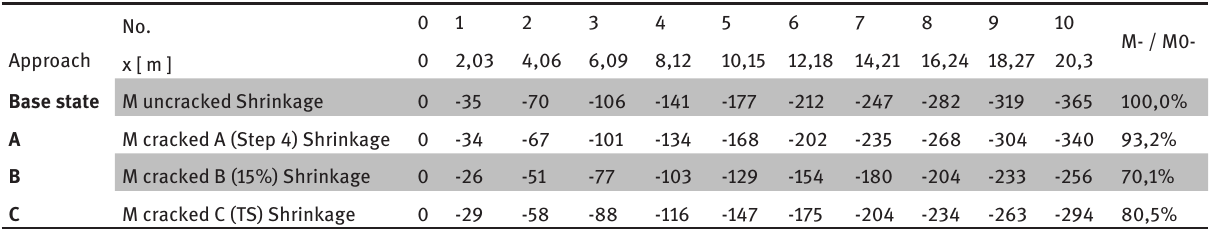
Table 3: Bending moment values (kN m) along the girder’s length (m) due to shrinkage in dependence of the assumed approach (A, B, C). Numerical interpretation of Fig.